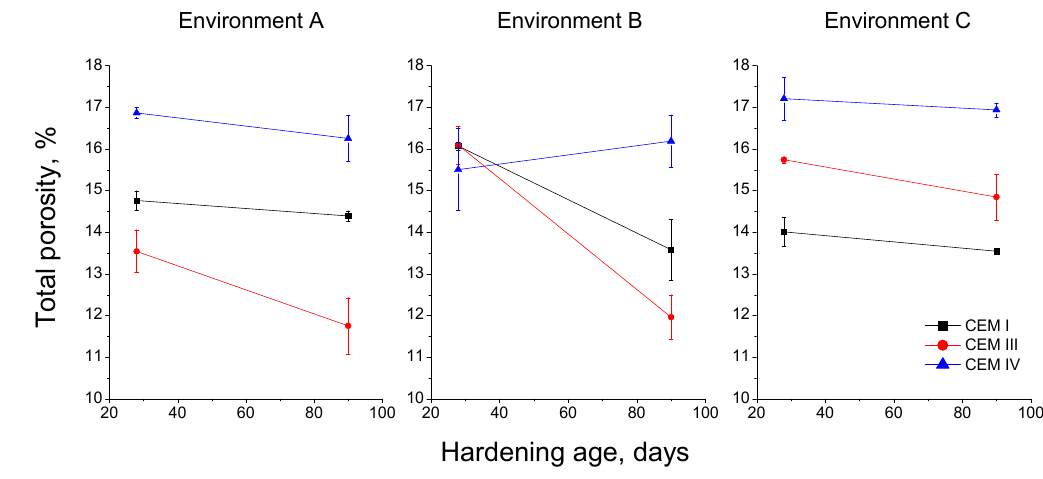
Figure 7. Results of total porosity for the studied mortars.